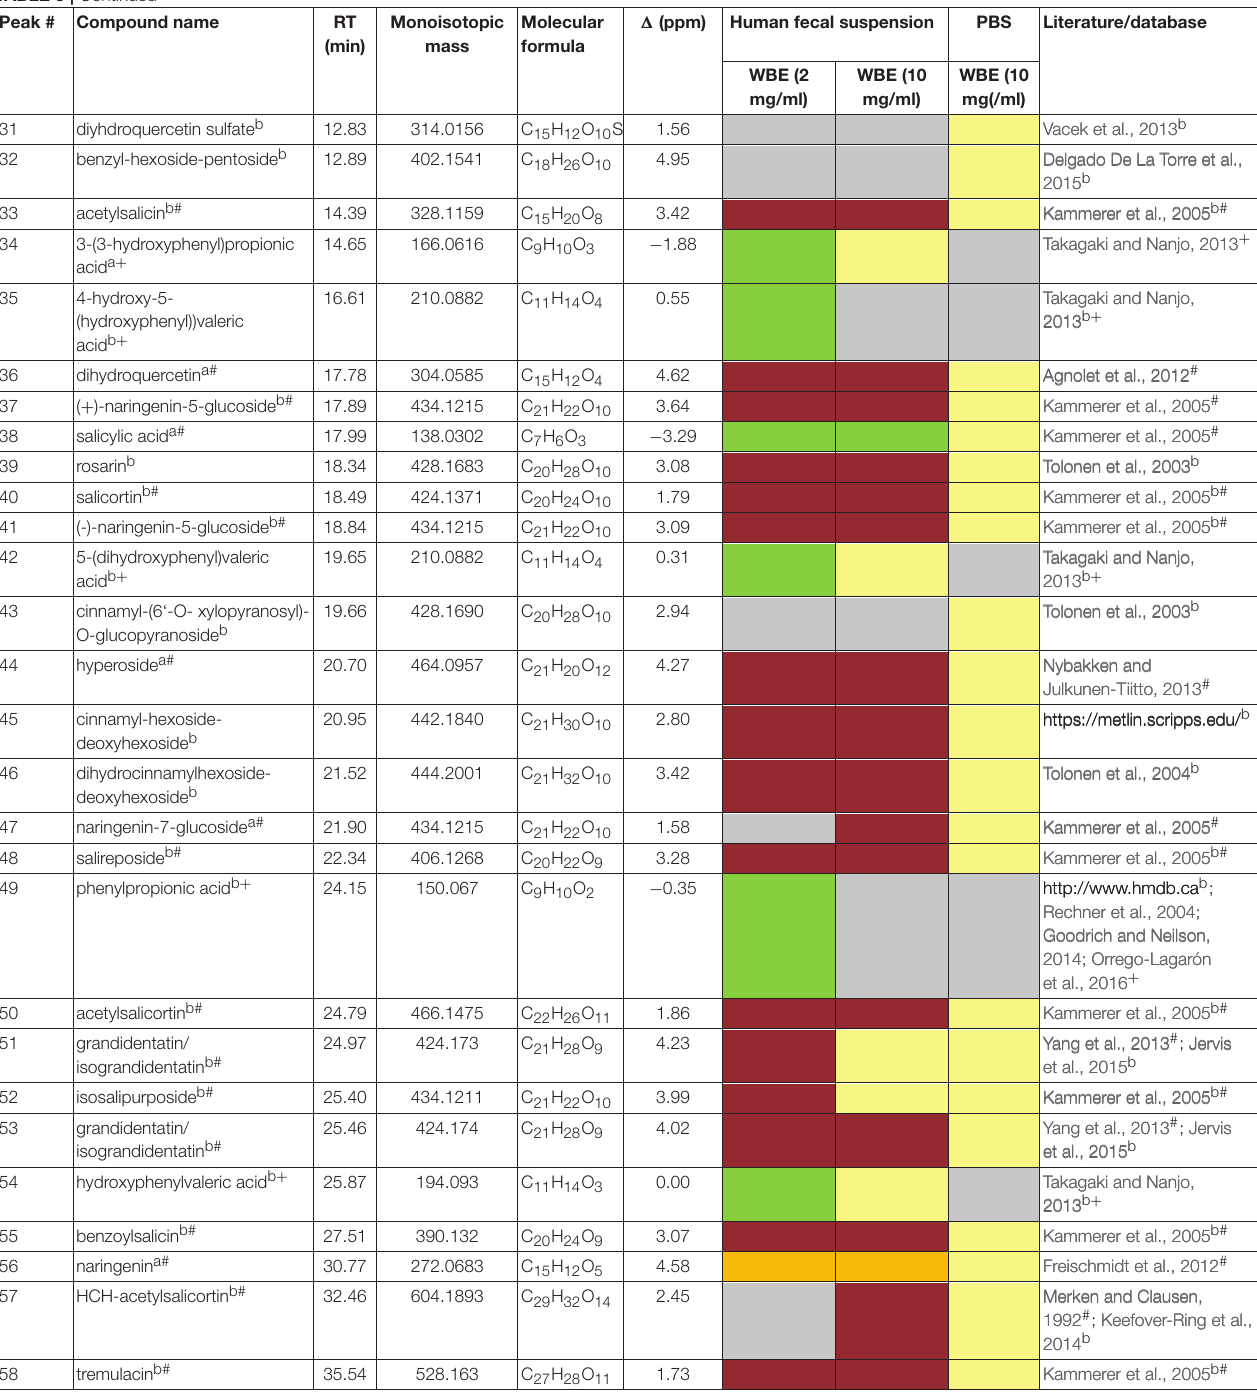
b Tentative identification based on monoisotopic mass and comparison with fragmentation patterns in literature or databases (HMDB, Metlin, Massbank, mzCloud; for details, see Supplementary Data Sheet 1); structural isomers cannot be ruled out; # Described in the literature in Salix sp; + Described in the literature as intestinal/fecal metabolite. Color code: Decreasing over 24h (ratio t0/t24 < 0.5, p <